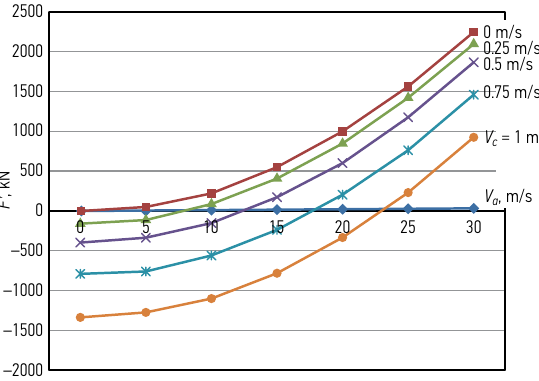
Fig. 6. Horizontal force F ′ produced by PANAMAX tanker moving at speed v y in Y direction (abeam) at the rate of 0.2 m/s) depending on the velocity of the current and wind ( F ′ ‘+’ – the ship moving towards the quay wall; F ′ ‘–’ – the ship leaving the quay wall)